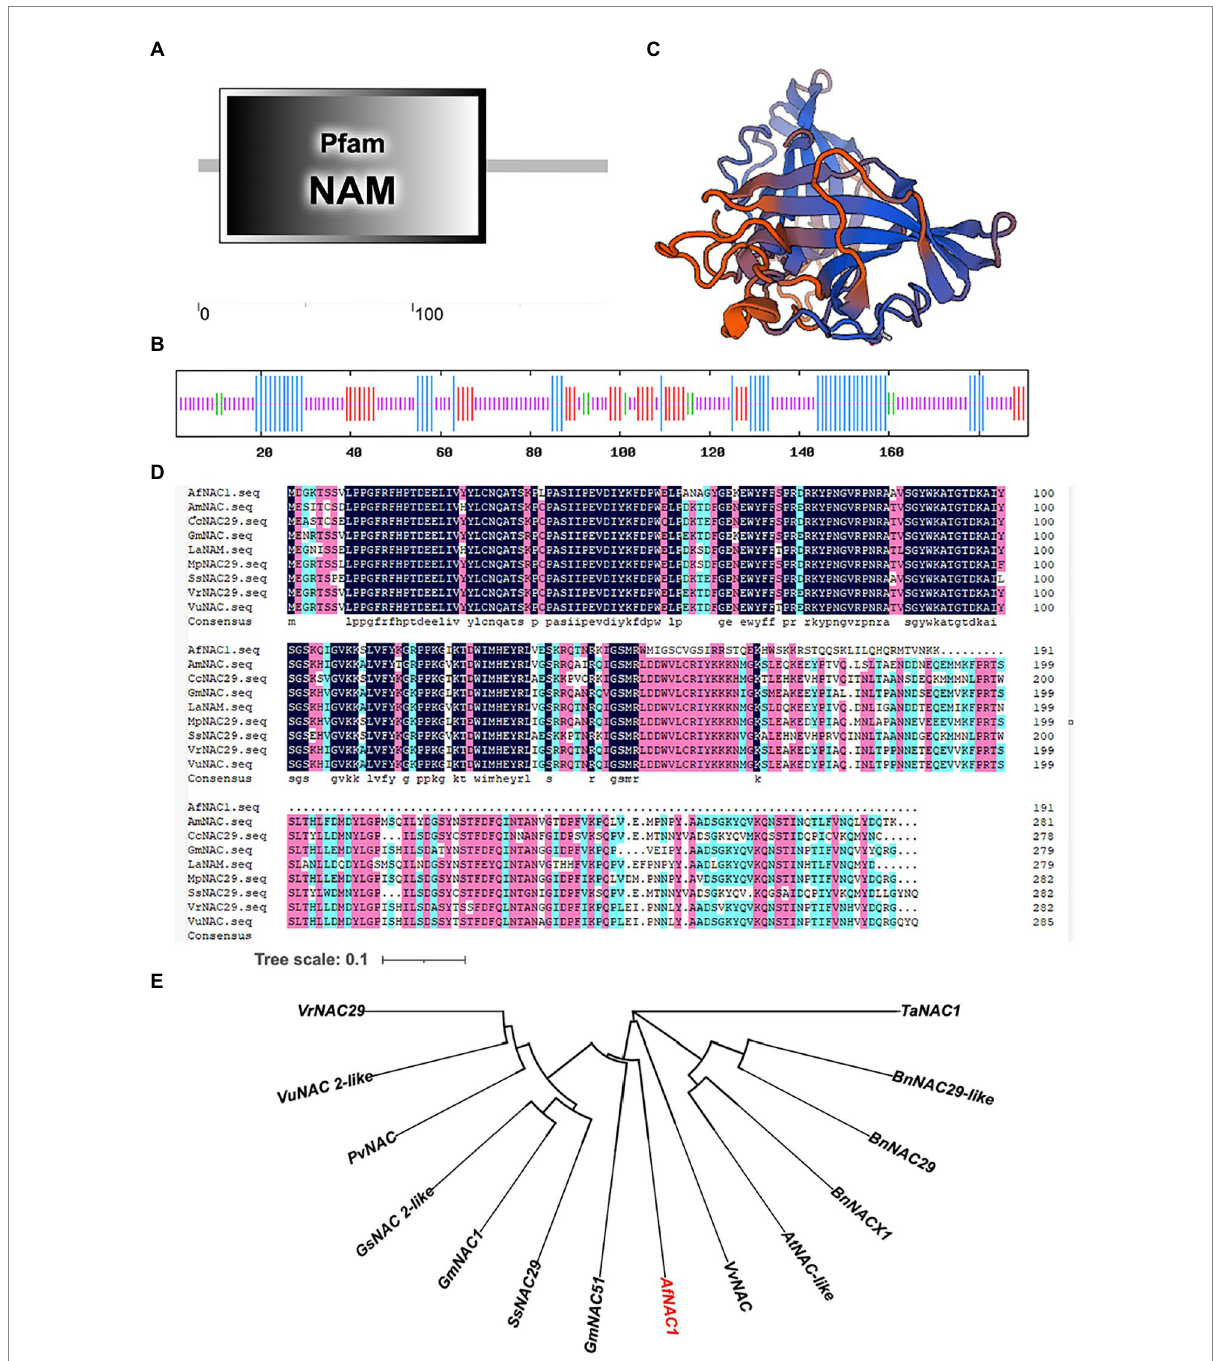
FIGURE 2 Results of bioinformatics analysis of the AfNAC1 gene. (A) Primary structure of the protein, including the NAM structural domain (1–100 aa). (B) Secondary structure, where the blue color indicates α -helix, the green color indicates β -steering, the red color indicates extended chain, and the purple color indicates irregular coiling. (C) Tertiary structure. (D) Results of multiple comparisons of amino acid sequences of NAC transcription factors with other different species. (E) Phylogenetic evolutionary tree. Scale bar indicates 0.1 amino acid substitution per